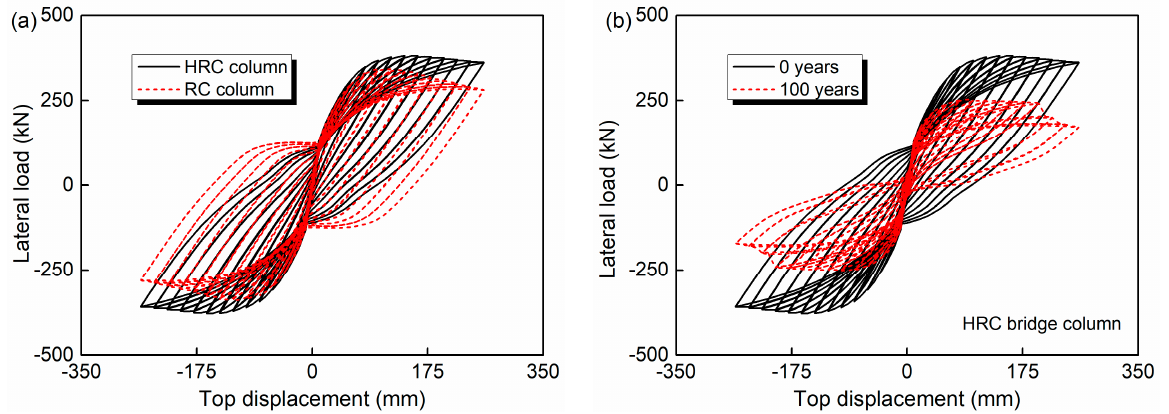
Figure 8. Lateral load-displacement curves: ( a ) HRC and RC bridge column at 0 years; ( b ) HRC bridge columns at 0 and 100 years.